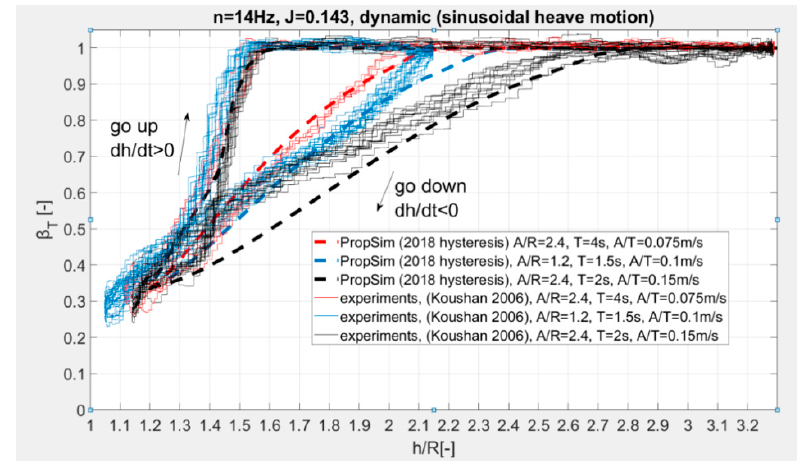
Figure 9. Comparison for thrust loss between experiments (dynamic) and simulations Comparison for thrust loss between experiments (dynamic) and simulations (PropSim2018_hysteresis) for different amplitudes of the propeller (heave), see Case 1, 2, and 3 (PropSim2018_hysteresis) for di ff erent amplitudes of the propeller (heave), see Case 1, 2, and 3 presented in Table 2, simulation includes hysteresis the effect for two different motions of the presented in Table 2, simulation includes hysteresis the e ff ect for two di ff erent motions of the propeller propeller (upwards and downwards), PropSim2018_hysteresis. (upwards and downwards), PropSim2018_hysteresis.